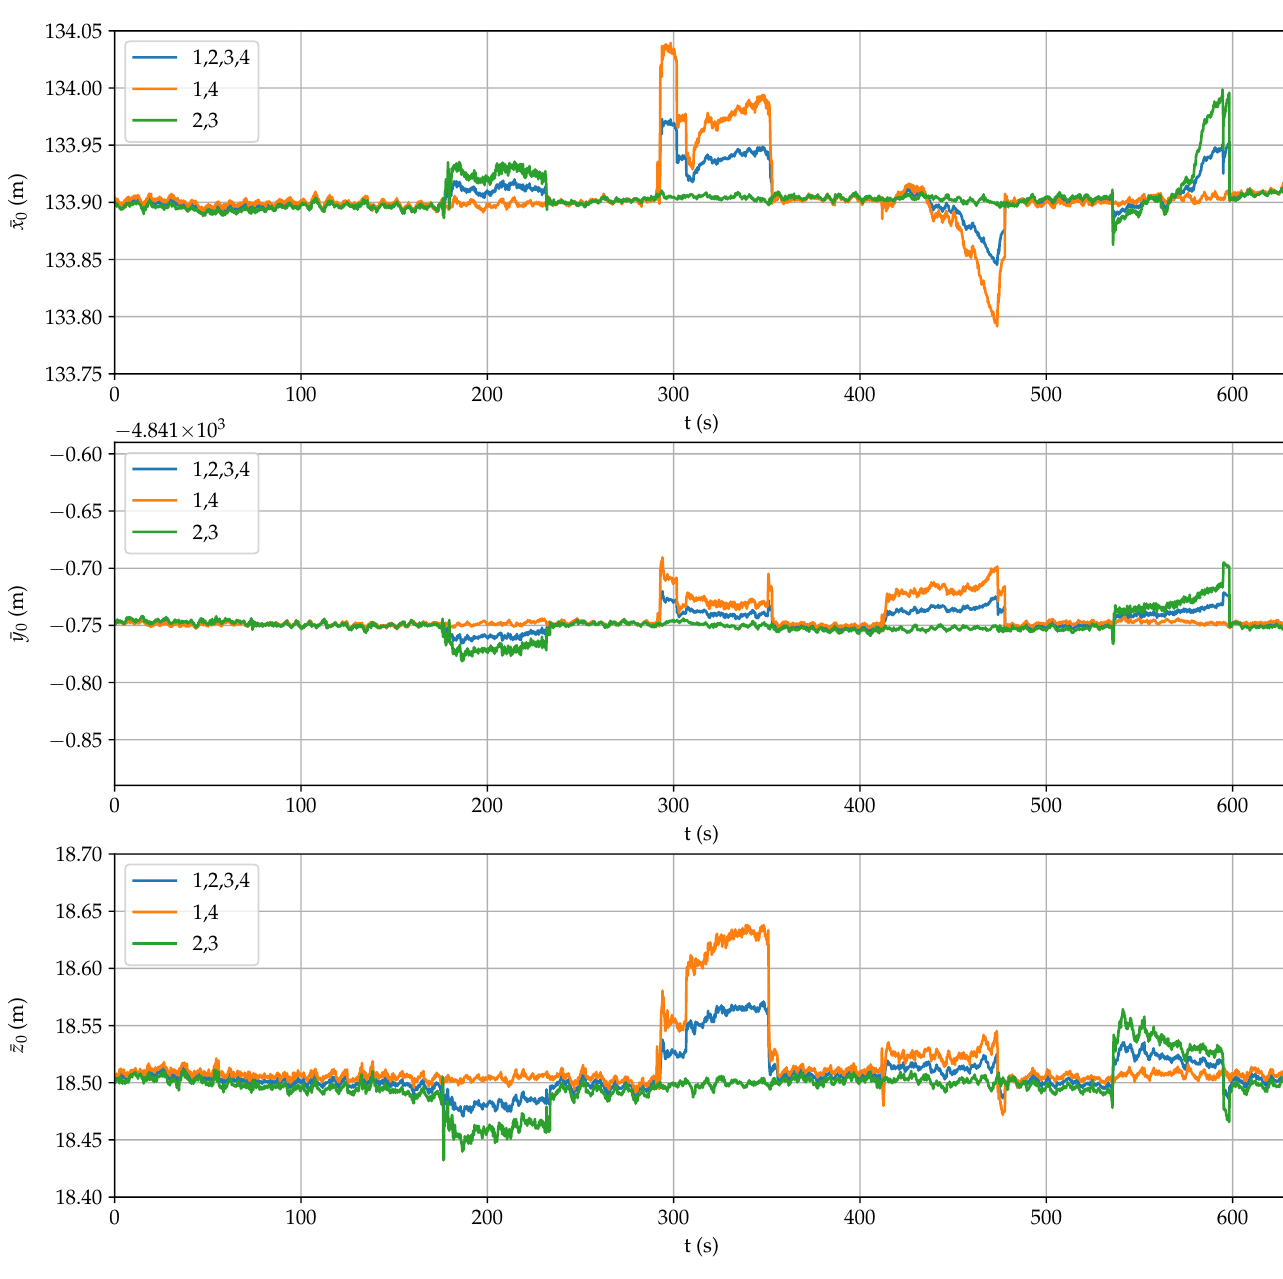
Figure 8. Estimation of position coordinates during the reliability